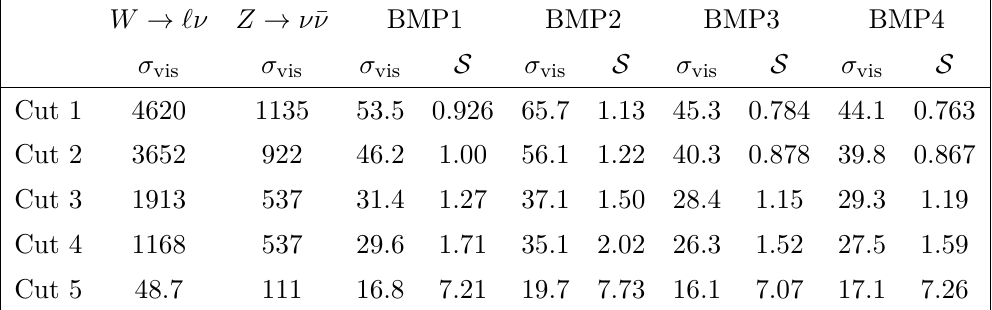
Table 3 . Visible cross section σ vis in fb for the backgrounds and signal BMPs after each cut in √ the monojet + /E channel at s = 100 TeV . The signal significance S corresponds to integrated T luminosity 3 ab − 1 for β = 1% and γ = 10%